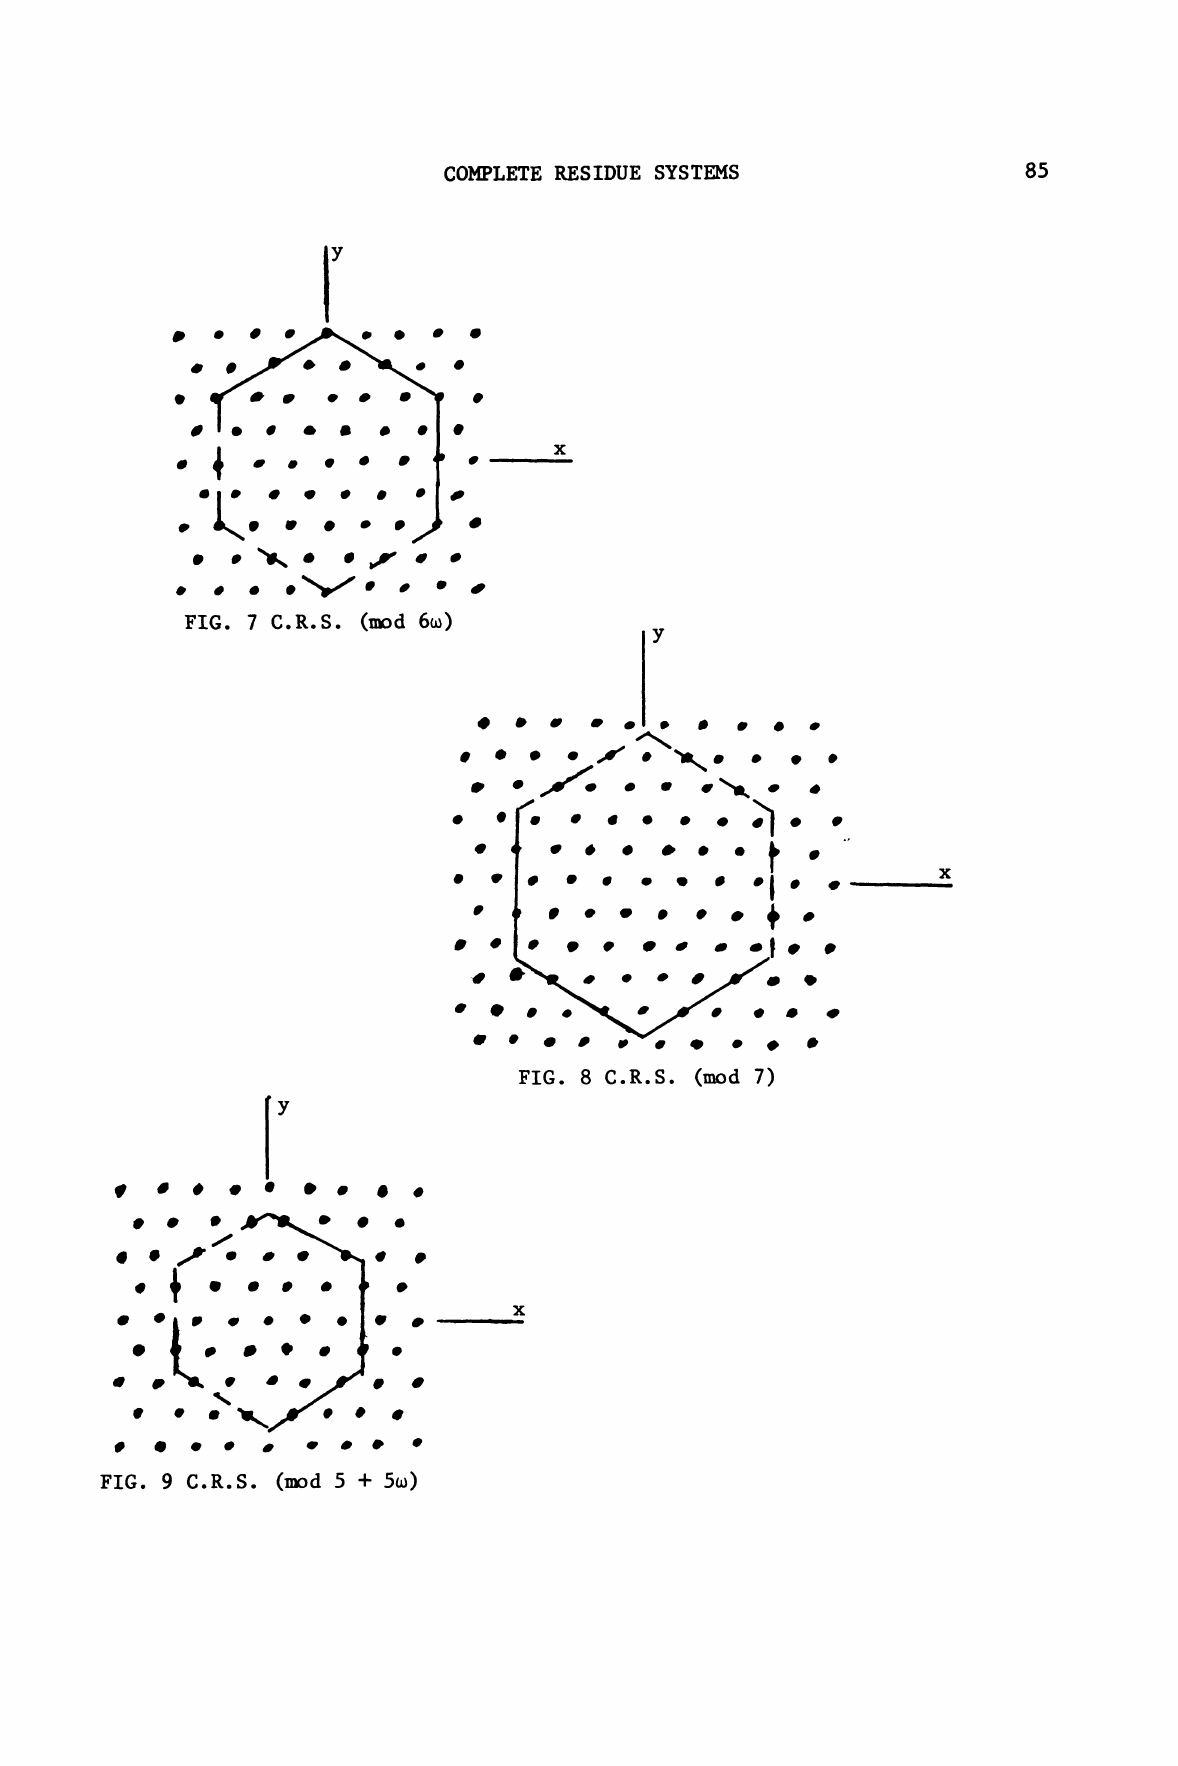
FIG. 9 C.R.S. (rood 5 + 5)